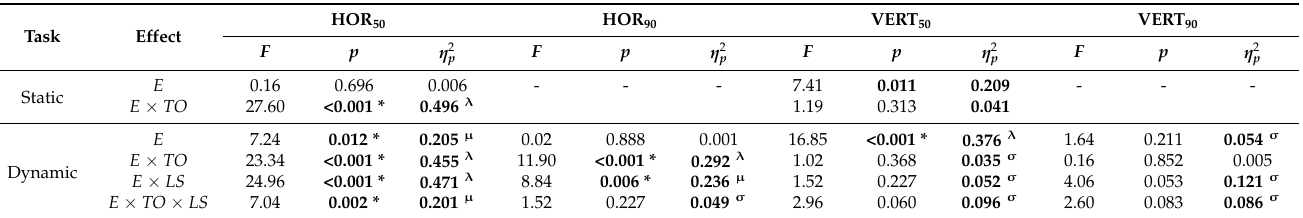
Table A5. F -values and p -values of the repeated measures ANOVAs with corresponding effect sizes (partial eta squared ( η 2 p )). Main effects of the Exoskeleton condition ( E ) and the interaction effects for E with Trunk orientation ( E × TO ), E with Lifting style ( E × LS ) and E with TO and LS ( E × TO × LS ) for static and dynamic work tasks.